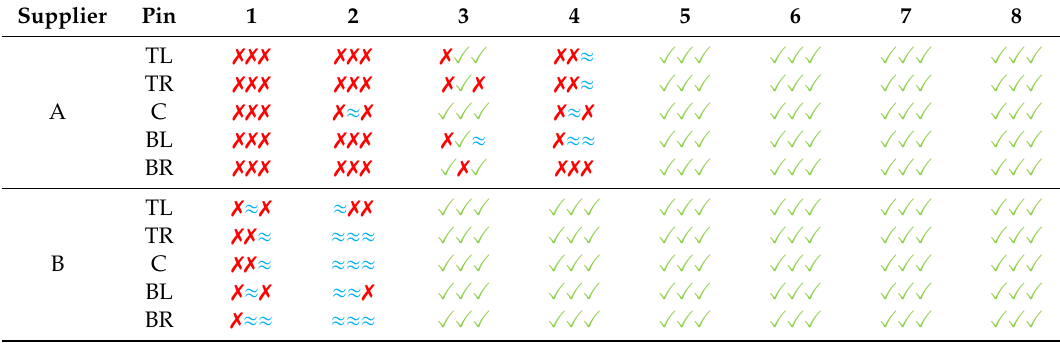
Table 7. Pin construction summary for each company. ✓ acceptable; ≈ uncertain; ✗ not built.